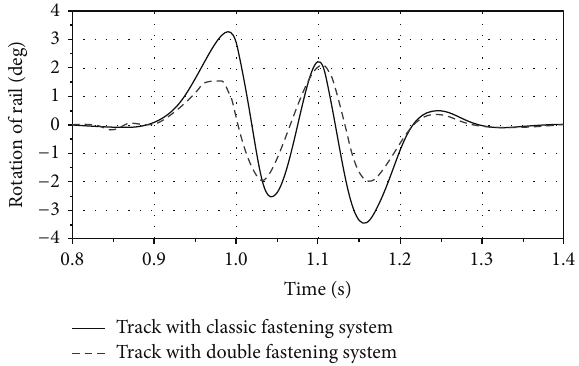
Figure 9: Rail rotation in the tracks with different sleepers and fastening systems at the vehicle speed